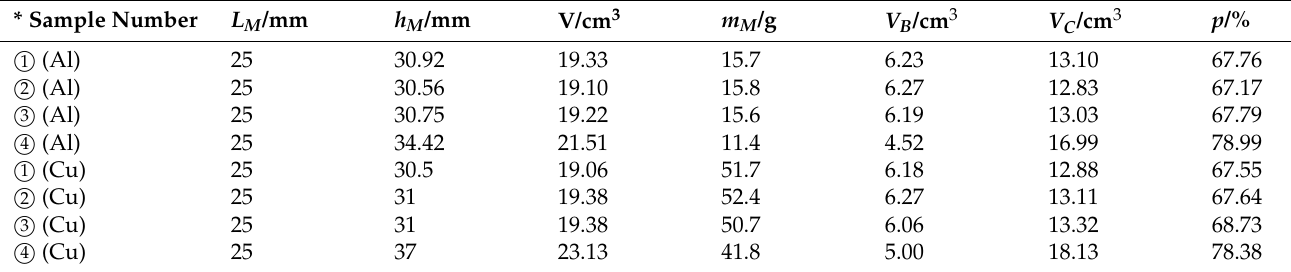
Table 2. Actual porosity 𝑝 of foam samples.